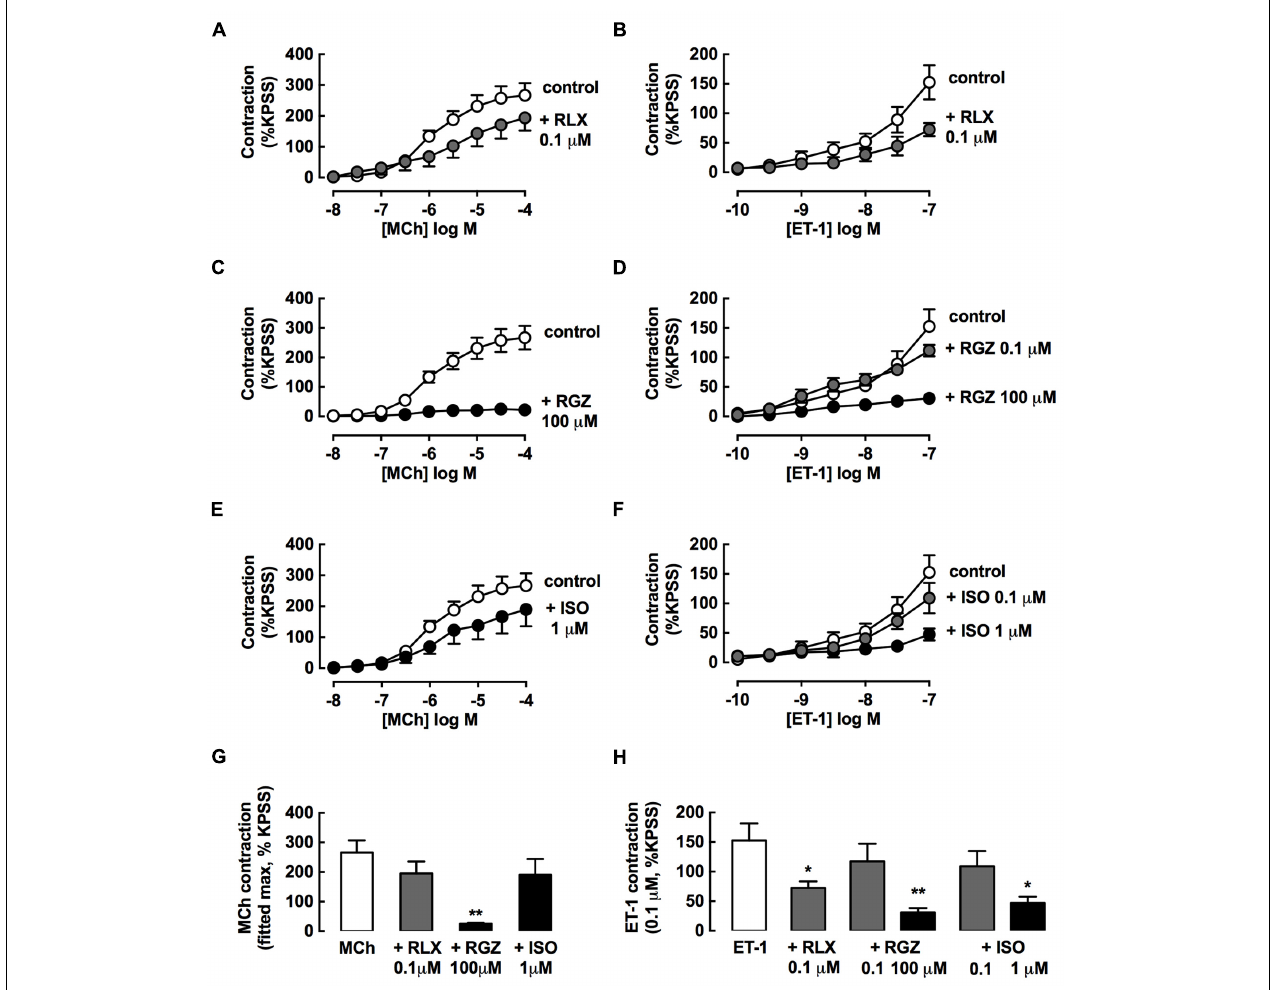
FIGURE 5 | rhRLX and RGZ, but not ISO, inhibit the development of tracheal contraction. The effects of pretreatment with rhRLX (RLX), RGZ and ISO (30 min) on the development of contraction to MCh (left panels) and ET-1 (right panels) were assessed, testing (A,E) RLX (0.1 µ M), (B,F) RGZ (0.1, 100 µ M), and (C,G) ISO (0.1, 1 µ M). For clarity, the same control data is shown on panels (A–C) for MCh and panels E-G for ET-1. (D) Maximum contraction to MCh determined from fitted concentration-responses curves using GraphPad Prism. (H) Contraction to the highest tested concentration of ET-1 (0.1 µ M). All responses are expressed as % KPSS standard contraction (mean ± SEM, n = 4–5 per group). ∗ P < 0.05, ∗∗ P < 0.01 vs. MCh or ET-1